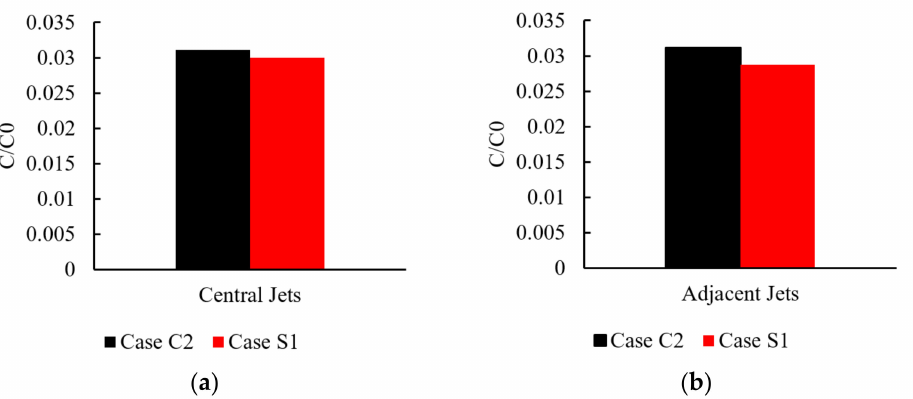
Figure 12. Concentration at x/(D.F d ) = 3.4 and the elevation of nozzle tip on the centerline planes of ( a ) central and ( b ) adjacent